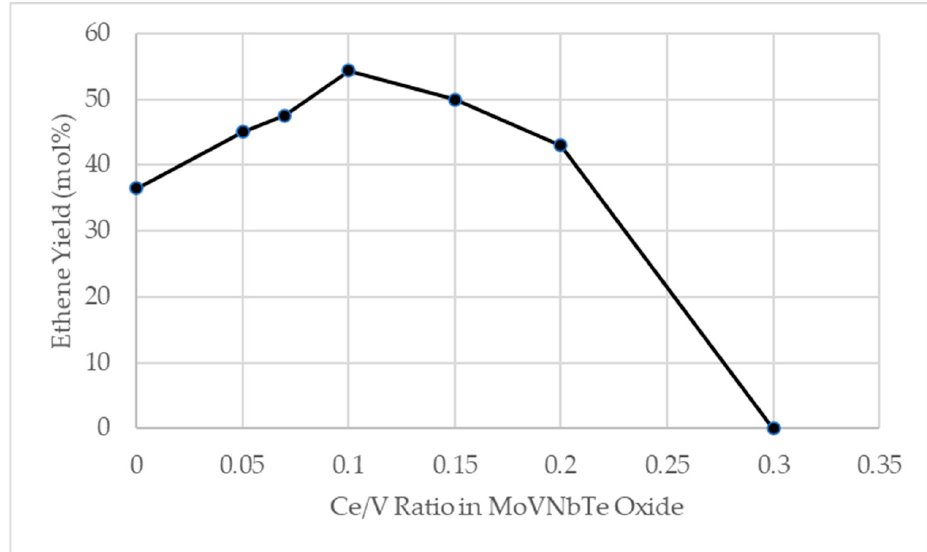
Figure 4. Ethane ODH with MoVTeNb Oxide catalyst with varying levels of cerium content. Source [69].